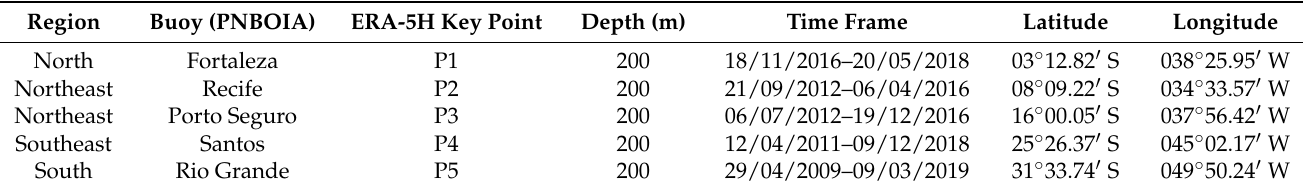
Table 2. Buoy details and their respective ERA-5H key